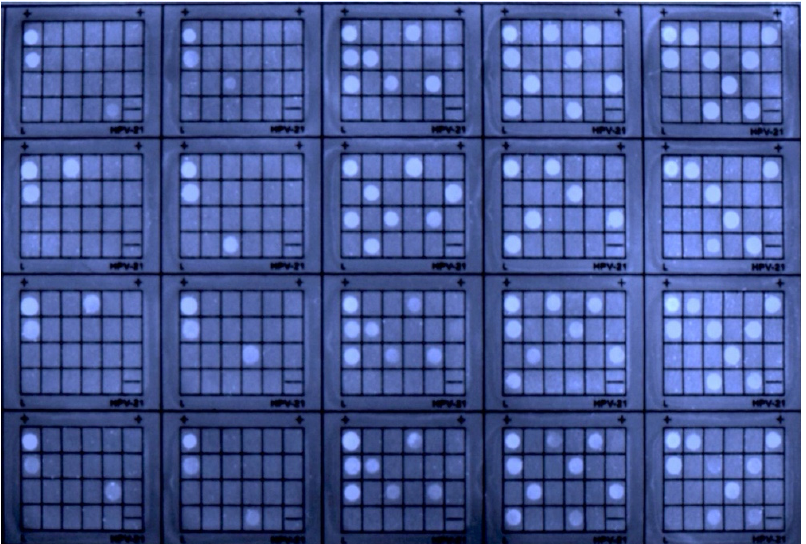
Figure 10. Photographs of the HybriMem stained with HCAP in the standard condition in the clinical trial. The photo of the automatic membrane reader was taken with a U3P camera. [HCAP] = 0.1 mM; probe incubation time: 5 min; PCR cycle: 40.